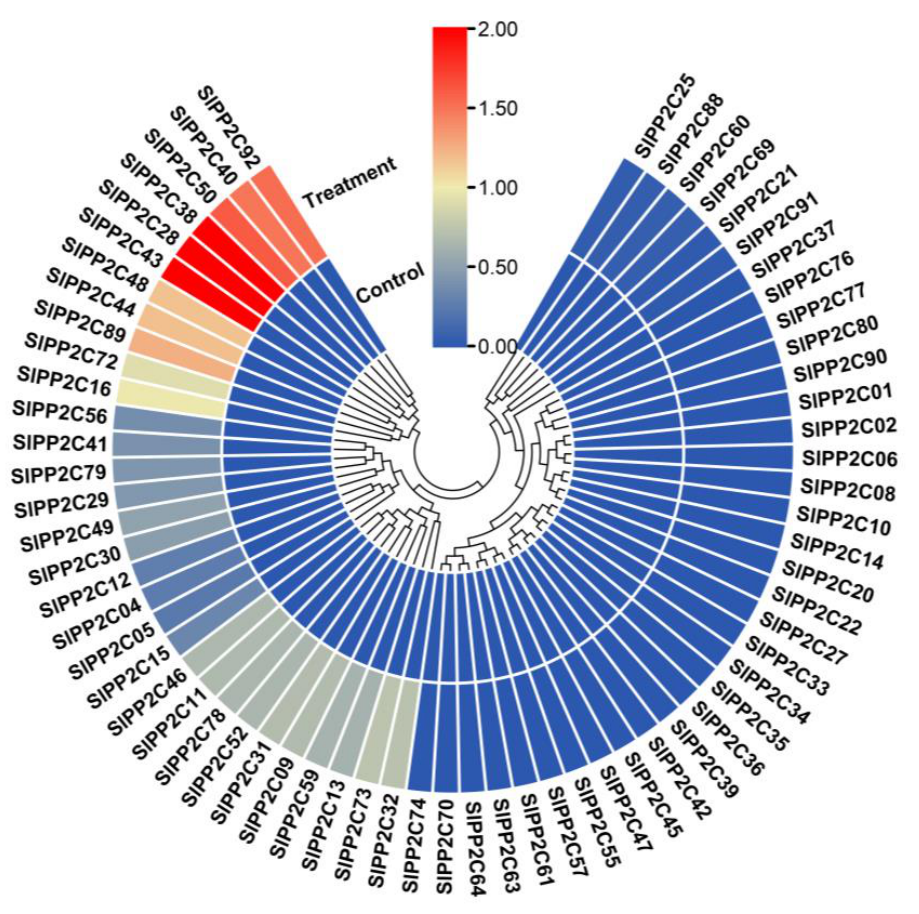
Figure 7. Expression profiles of SlPP2C genes in tomato roots infected by plant pathogen Ralstonia solanacearum . Blocks with colors represent decreased (blue) or increased (red) transcript levels relative to the control.